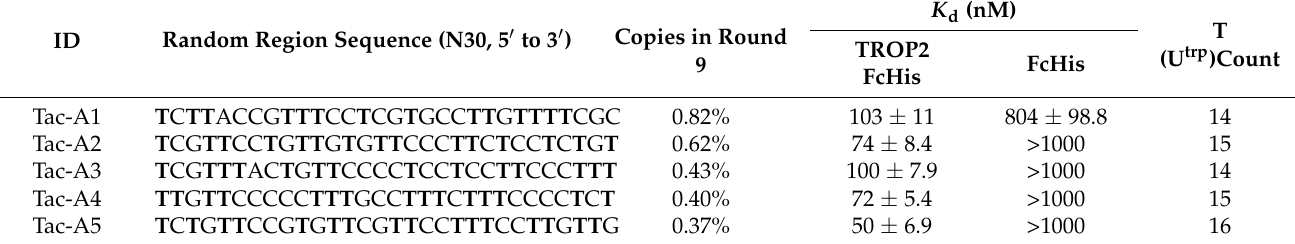
Table 1. Sequence and binding affinities of aptamers discovered using CE-SELEX.